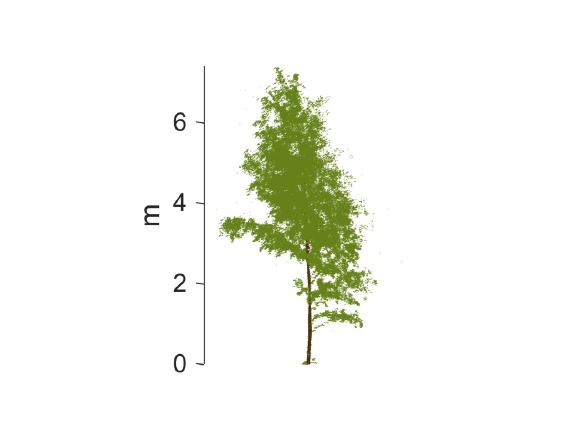
Figure 2. Point cloud of the Betula pendula , silver birch. a projection of points onto the horizontal plane. For details of fea- ture extraction procedures, the readers are referred to Weinmann et al.